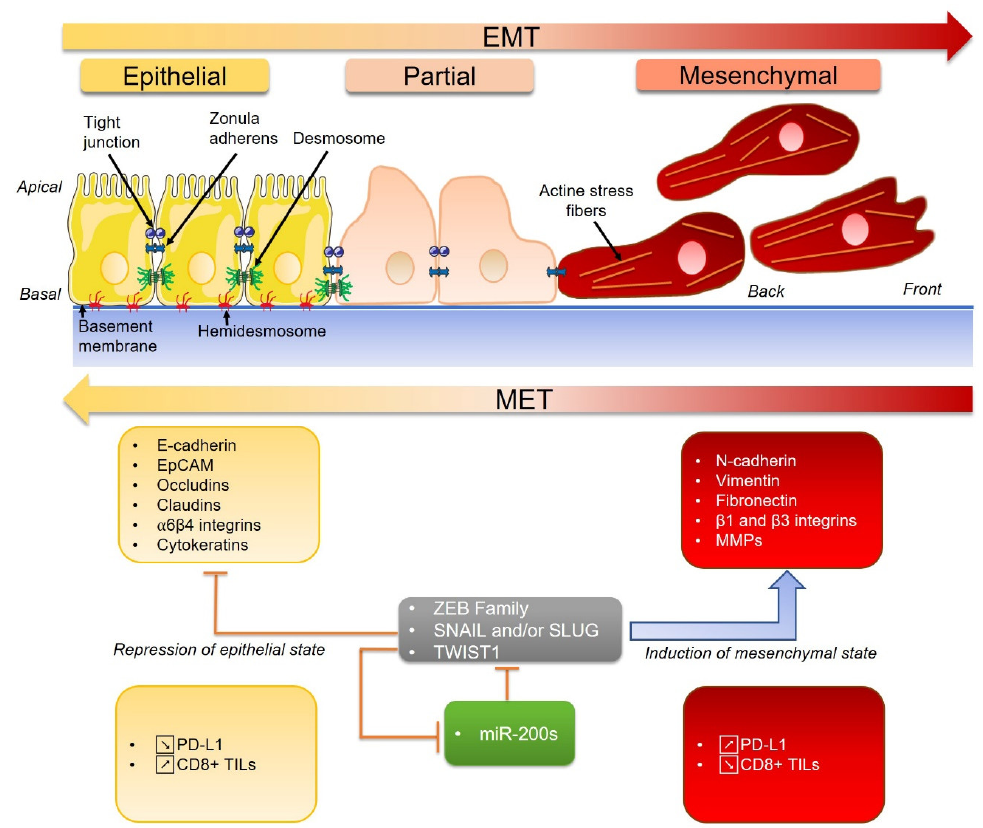
Figure 2. The regulation of the epithelial-mesenchymal transition (EMT) by miR-200s and specific transcriptional factors. EMT = epithelial-mesenchymal transition, MET = mesenchymal-epithelial transition and MMPs = matrix metalloproteinases.